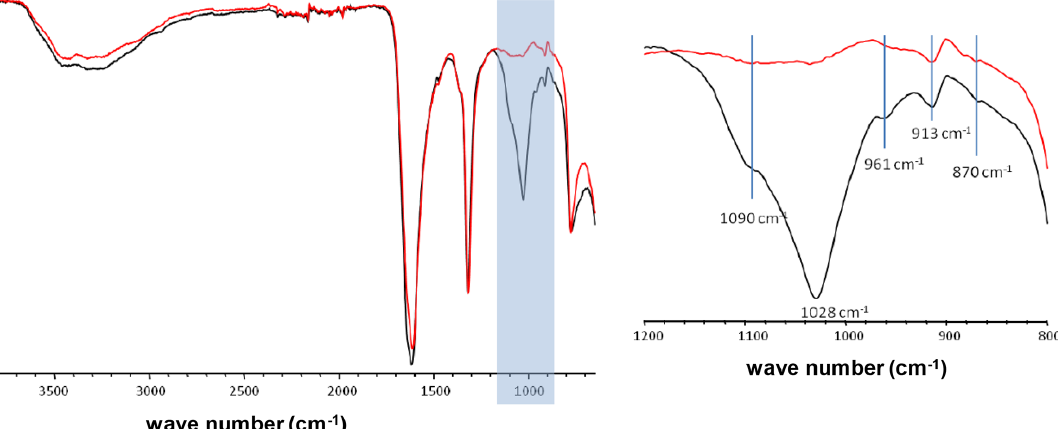
Figure A1. FTIR spectra of two KSs containing a mixture of COM and COD phases. The main difference lies in the light blue wave number